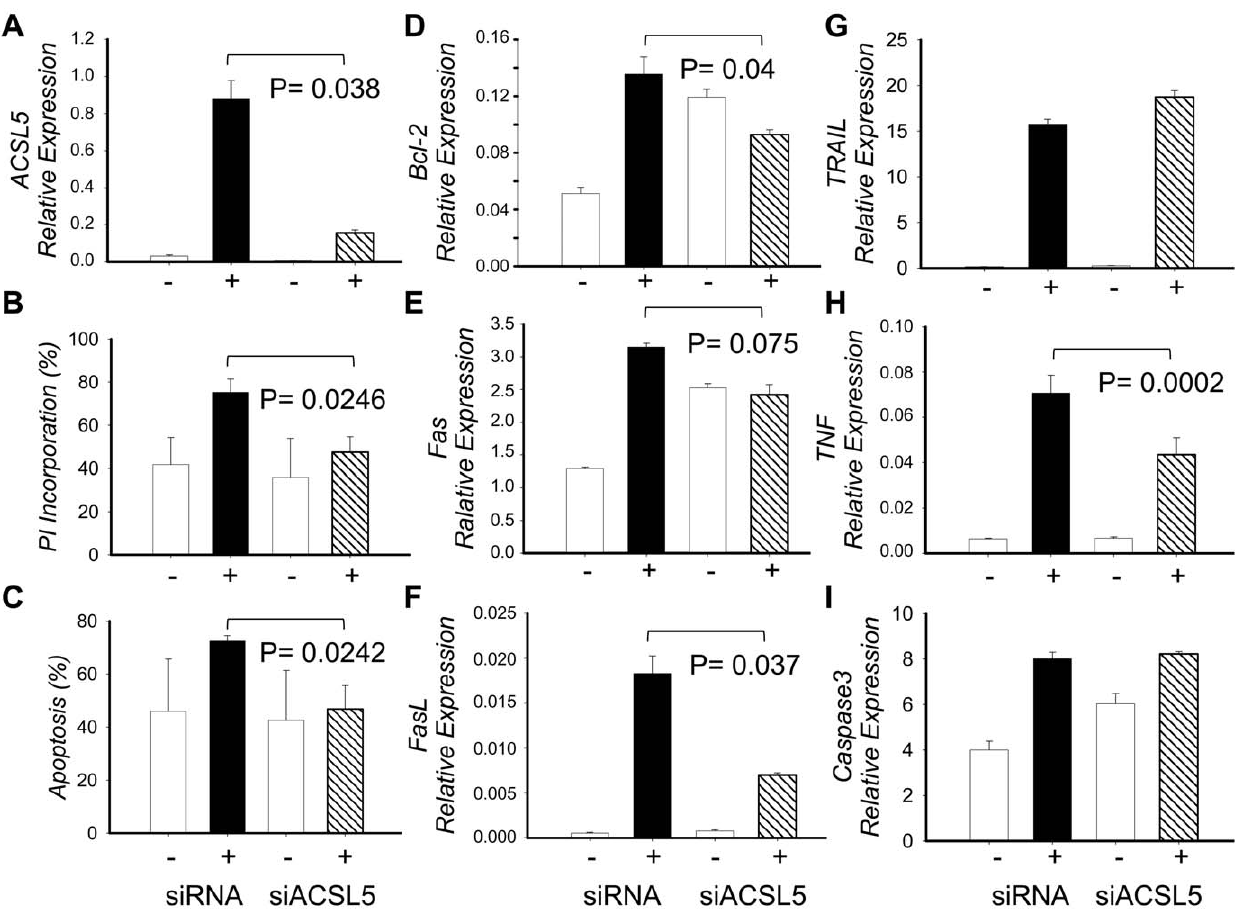
Figure 4. Effect of ACSL5 silencing in the apoptosis induced in Jurkat T cells by PMA + Io activation. Jurkat T cells were electropororated with either siRNA for ACSL5 (siACSL5) or unspecific control of siRNA (siRNA), and left for 18 h in culture media. Then both siACSL5 and siRNA Jurkat T cells were cultured with or without PMA + Io for 24 h. A) ACSL5 expression at 24 h was determined in each type of culture as described in material and methods. B) Percentage of apoptosis in siACSL5 or siRNA Jurkat T cells measured by cytometry as Annexin V positive and double Annexin V and PI positive cells. C–I) Total RNA was extracted, cDNA synthesized and qRT-PCR implemented to determine mRNA expression. Results are given by means of three independent experiments and the bars show the standard deviation. P-value has been calculated with the paired Student t